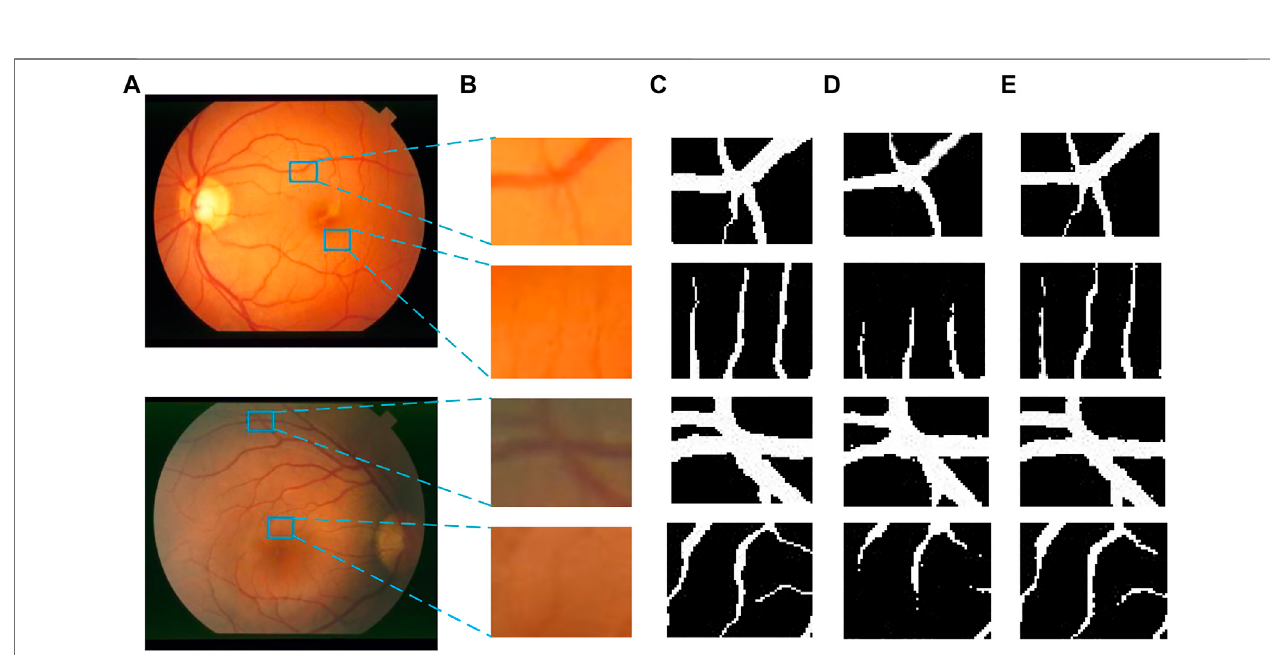
FIGURE 15 | Comparation of local segmentation effects on STARE data sets: (A) Original fundus image, (B) Original local image, (C) Local reference standard image, (D) Local segmentation results in Ref. (Fan et al., 2019), and (E) Local results by proposed method.